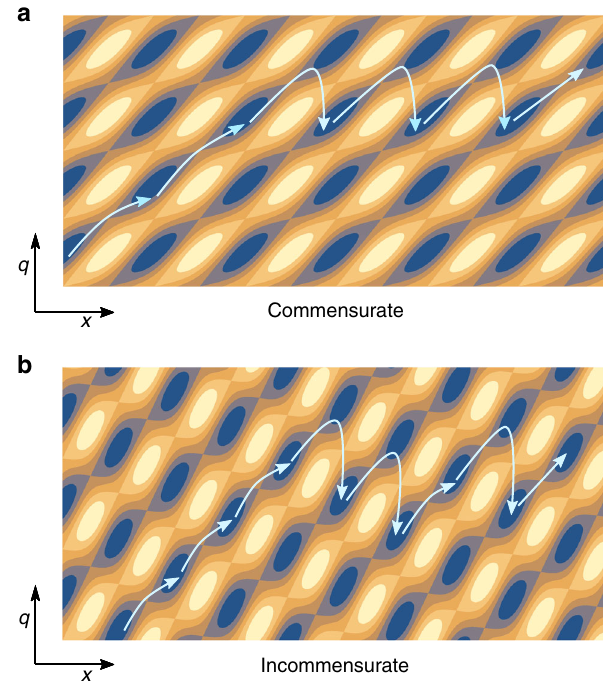
Fig. 5 A cartoon explaining the strengthening behaviour. The potential energy landscape and trajectory of the tip in the xq -plane for a commensurate and b incommensurate lattice parameters of the sheet and substrate. Blue indicates low values of the potential energy and yellow high values. We can understand the strengthening from the topology of this landscape.